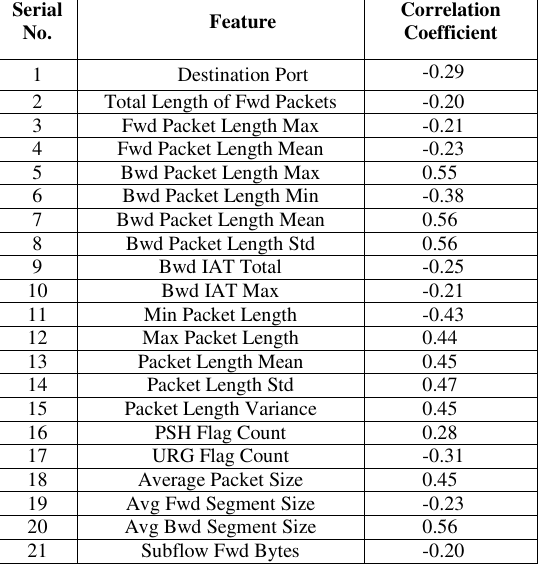
Table 2: Correlation based selected features for classification